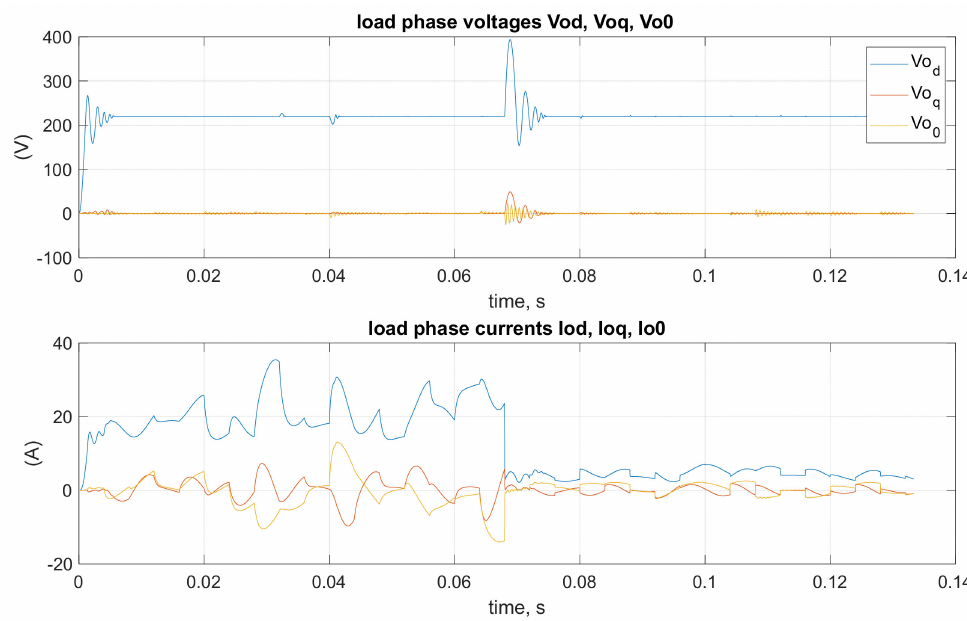
Figure 8. Waveforms of the islanded grid voltage V o and the distorted load current I o in the dq coordinate system with the applied limitations on the rotor current I r as well as the rotor voltage V r .